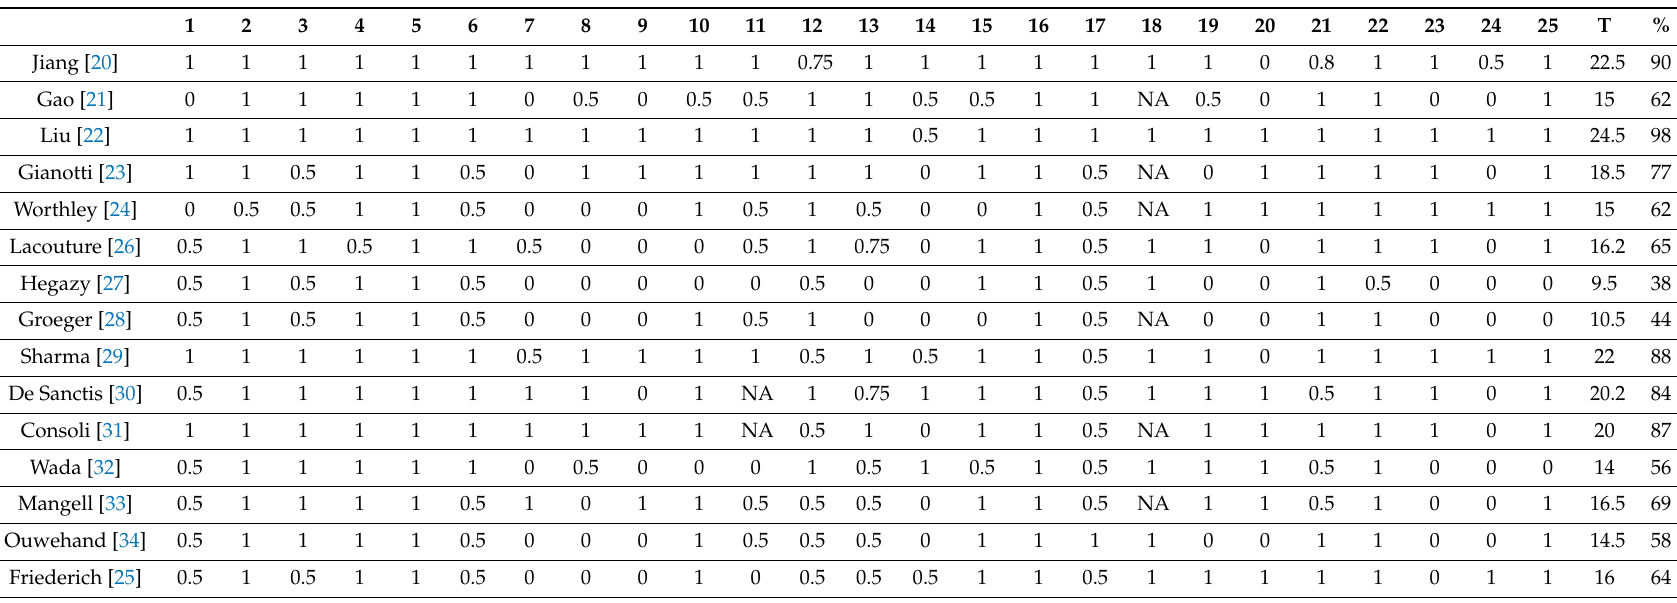
Table 3. Assessment of the methodological quality of the studies analyzed by means of the 25 items of the CONSORT